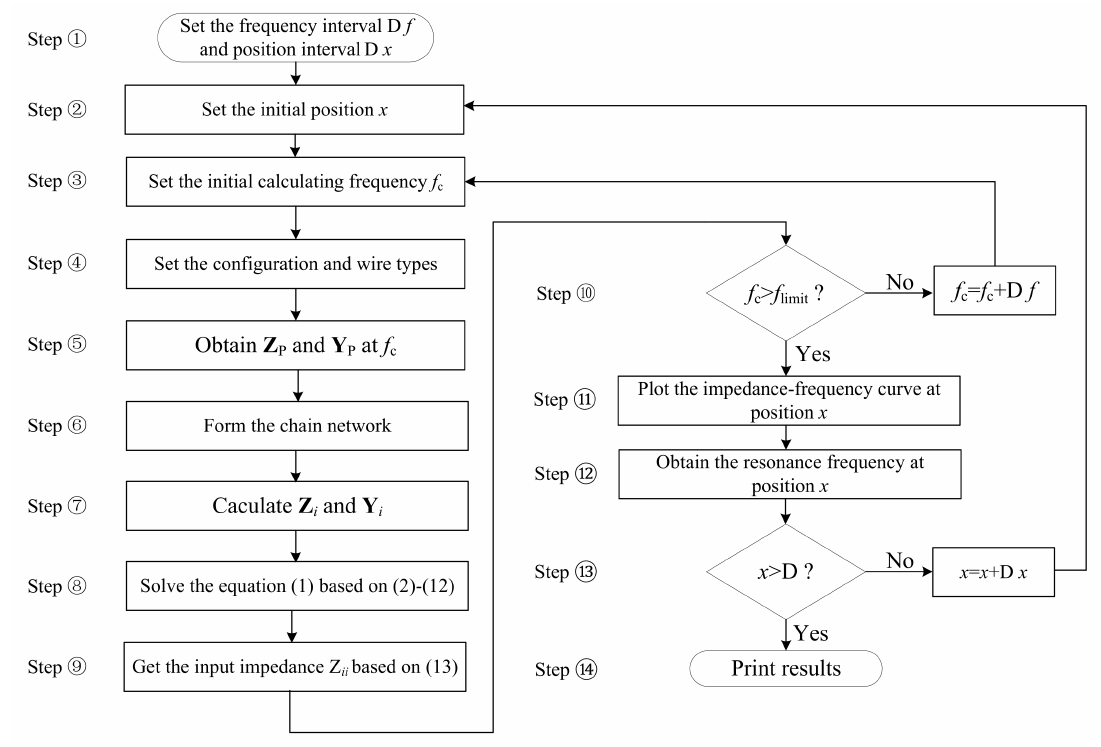
Figure 5. Flow chart of the identification of the resonance frequency at different